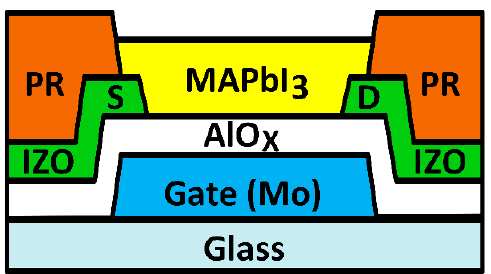
Figure 1. Schematic cross-section of the MAPbI 3 thin-film transistors (TFTs). During spin coating, the MAPbI 3 sink into holes (“banks”) formed in the photoresist (PR) layer. The source (S) and drain (D) electrodes are made of indium zinc oxide (IZO) and the gate insulator is AlO x .